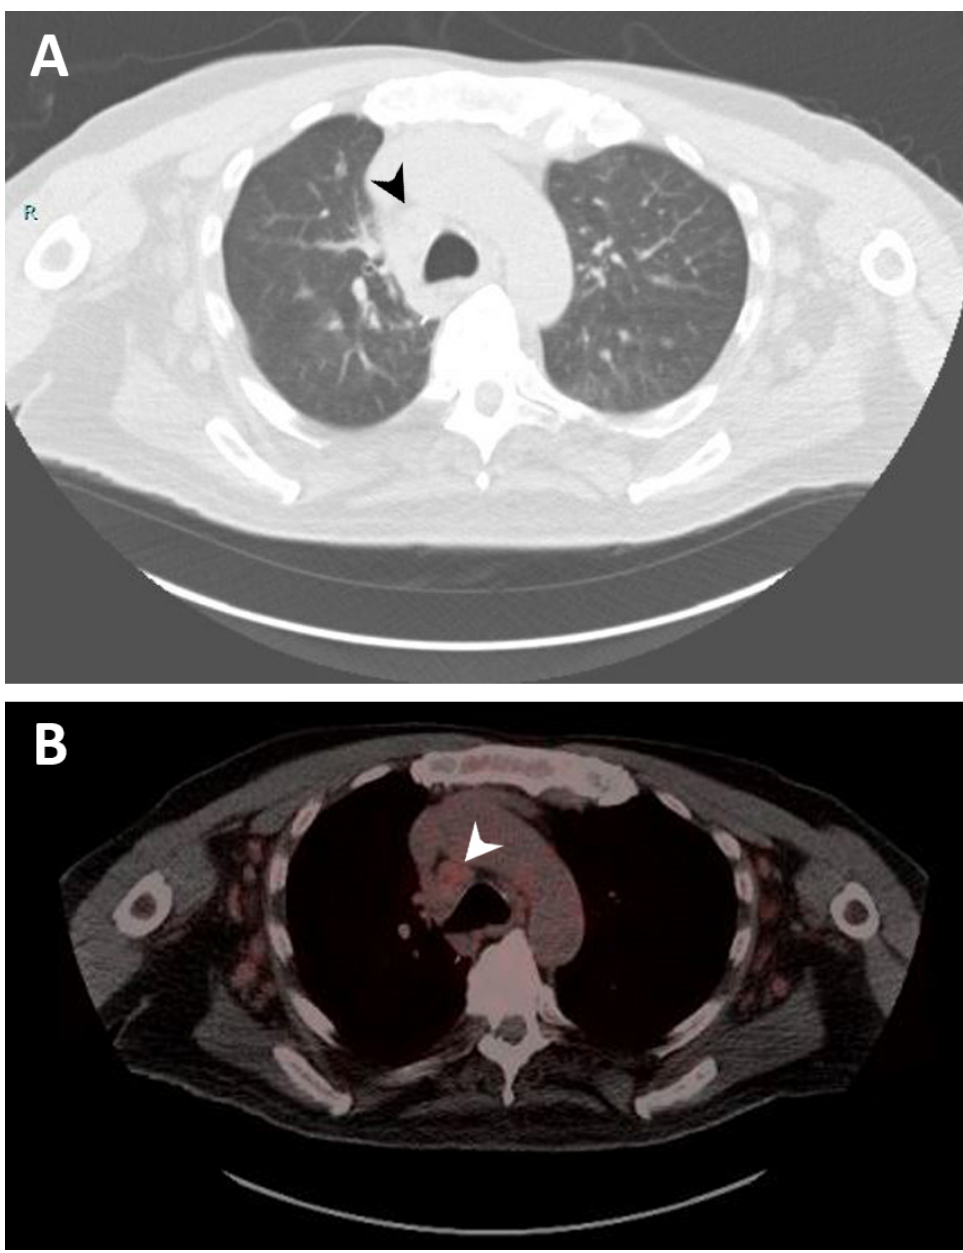
Figure 1. Imaging studies. (A) Computerized tomography (CT) scan of the chest showing right lower paratracheal lymphadenopathy measuring 2.1 cm (black arrow). (B) Gallium-68 dotatate positron emission tomography (PET)/CT scan of the chest demonstrating right lower paratracheal lymphadenopathy with mild radiotracer uptake, suggesting a neoplastic process related to mantle cell lymphoma (white arrow).